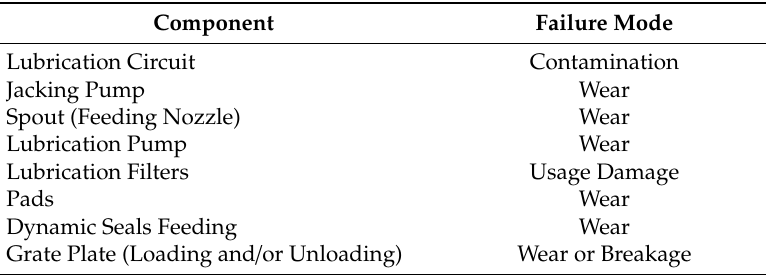
Table 8. Main failure modes of ball mill